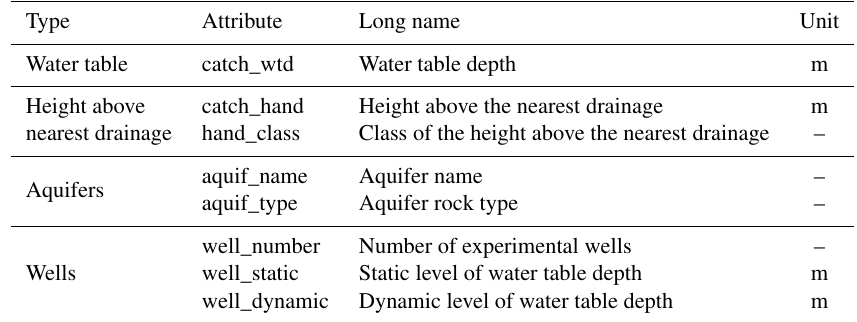
Table 5. Groundwater attributes of the CABra catchments.